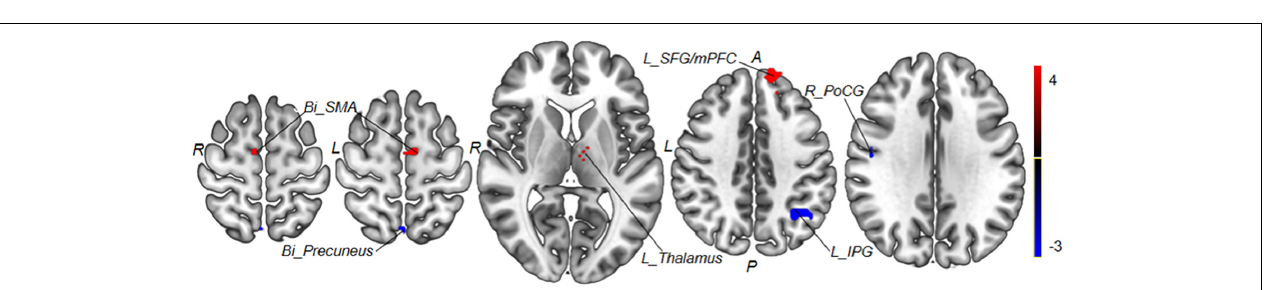
FIGURE 8 | Regions with the most predictive features. Positive weight brain areas with strong predictive power are located in the left thalamus, bilateral SMA, and left SFG/mPFC; negative weight brain areas with strong predictive power are located in the right PoCG, left IPG, and bilateral precuneus. Red colors indicate regions with positive weight; blue colors indicate regions with negative weight. Bi, bilateral; R, right; L, left; PoCG, postcentral gyrus; SMA, supplementary motor areas; SFG, superior frontal gyrus; mPFC, medial prefrontal cortex; IPG, inferior parietal gyrus.